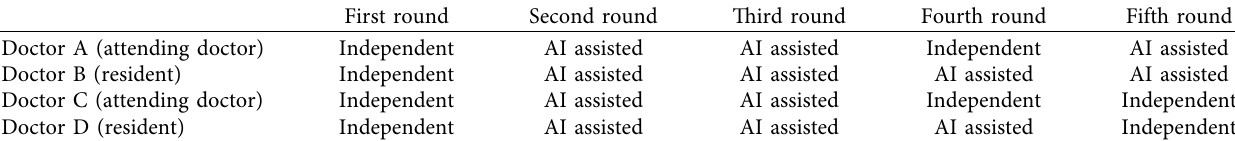
Table 1: Process diagram of